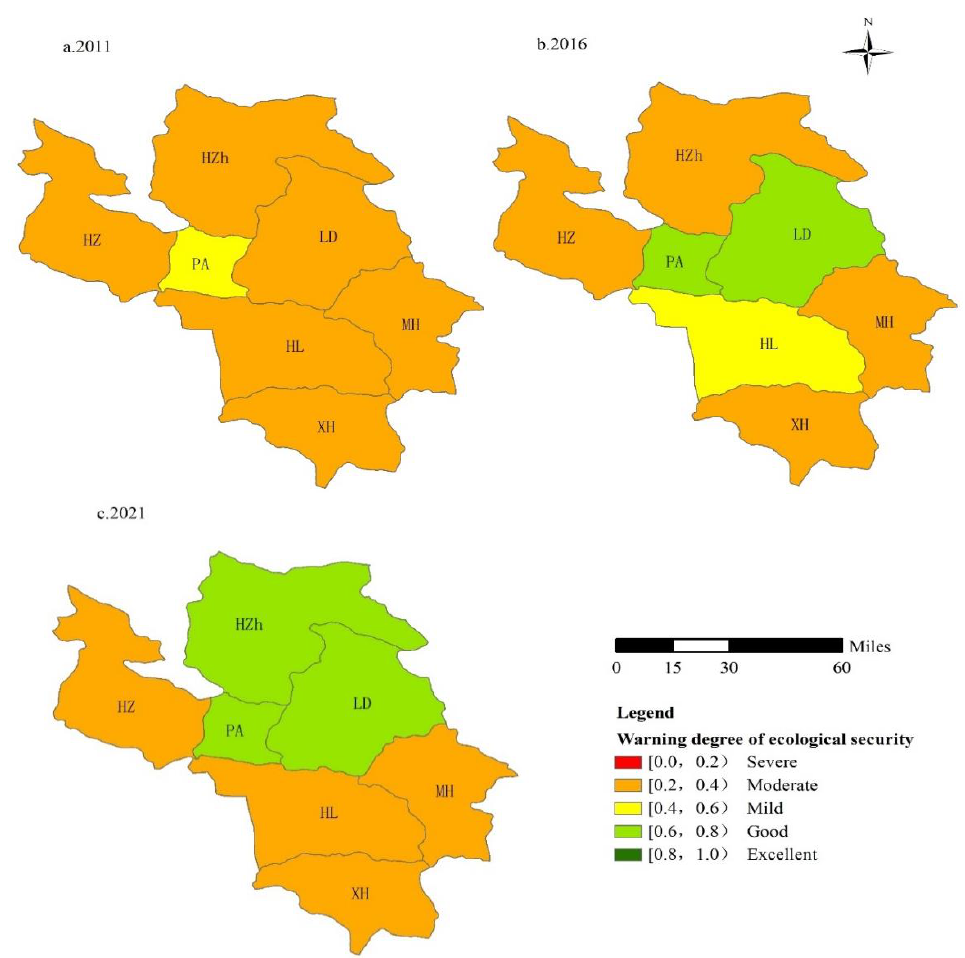
Figure 5. Regional distribution of ecological security warnings in the Qinghai alpine agricultural mountainous area in 2011, 2016 and 2021 (The letters “a”, “b”, and “c” represent the spatial differentiation pattern of the three research time periods of the initial, intermediate, and forecast (final) respectively).